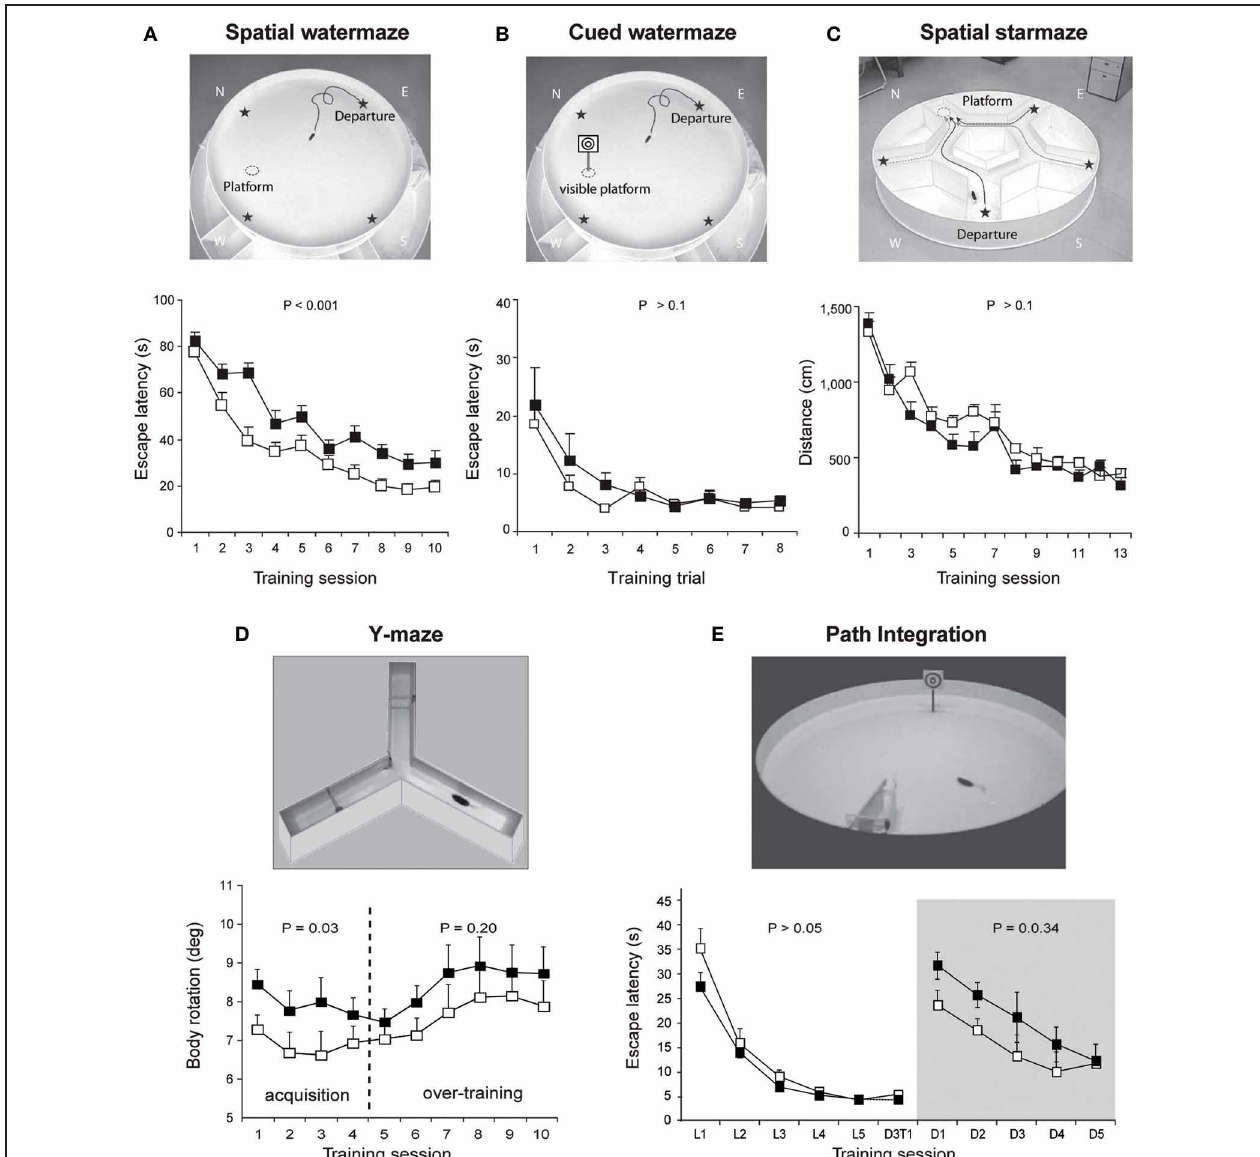
analysis of trajectory quality. Trajectories optimization was quantified by the body rotation parameter which measures the angle between 3 successive points of the trajectory and is averaged over the whole path. Body rotation was specifically impaired in L7-PKCI mice during the acquisition of the task. (E) The inability of L7-PKCI mice to navigate in the dark (i.e., using self-motion information) was revealed in a path integration task, in which mice have to find a platform in a constant location and from a fixed departure point with an alley guiding the initial orientation of the body. In this task, mice first learn the path in the light and then reproduce it in the dark. (A,B,C) Data from Burguiere et al. (2005); (D) data from Burguiere et al. (2010); (E) data from Rochefort et al. (2011). N, W, E, S: North, West, East, and South, respectively. Stars on the pictures in (A,B,C) indicate each possible departure